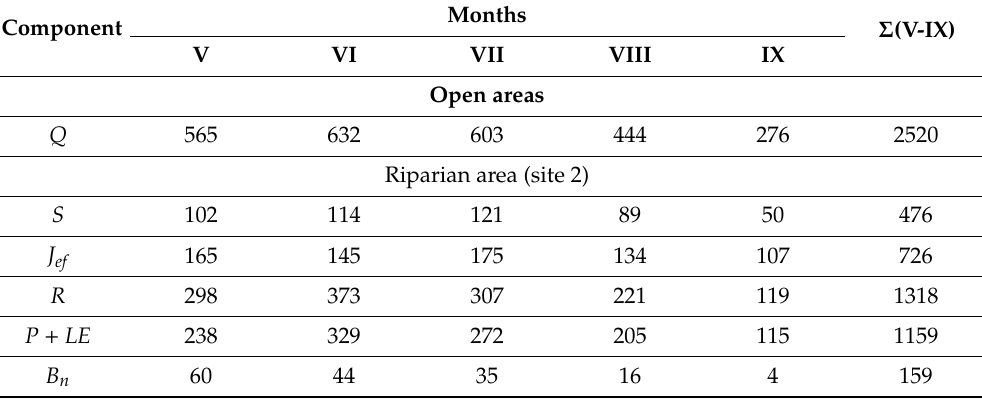
Table 2. Surface energy balance components at the Chabyda sites, MJ / m 2